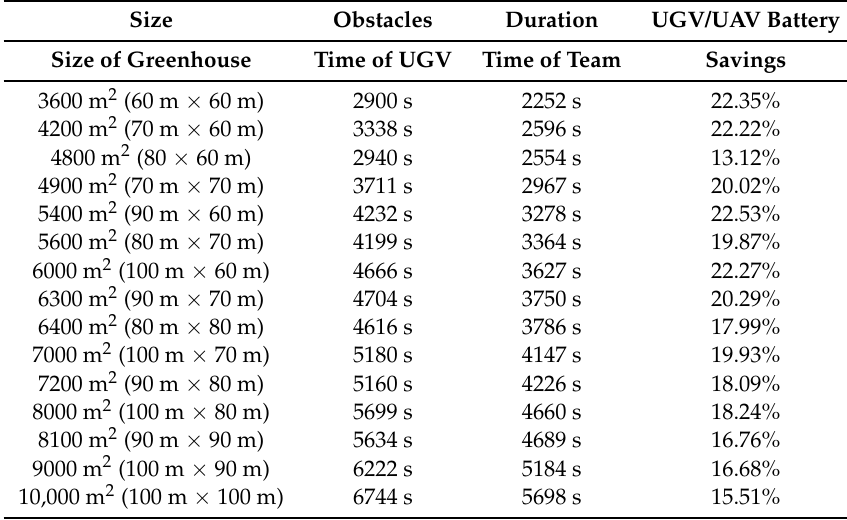
Figure 10. Application of the team strategy in simulations: ( a ) First simulation: the UAV covers two corridors, and the UGV covers the rest; ( b ) Second simulation: the UAV avoids the obstacle, while the UGV turns back. Table 6. Team performance according to greenhouse sizes and